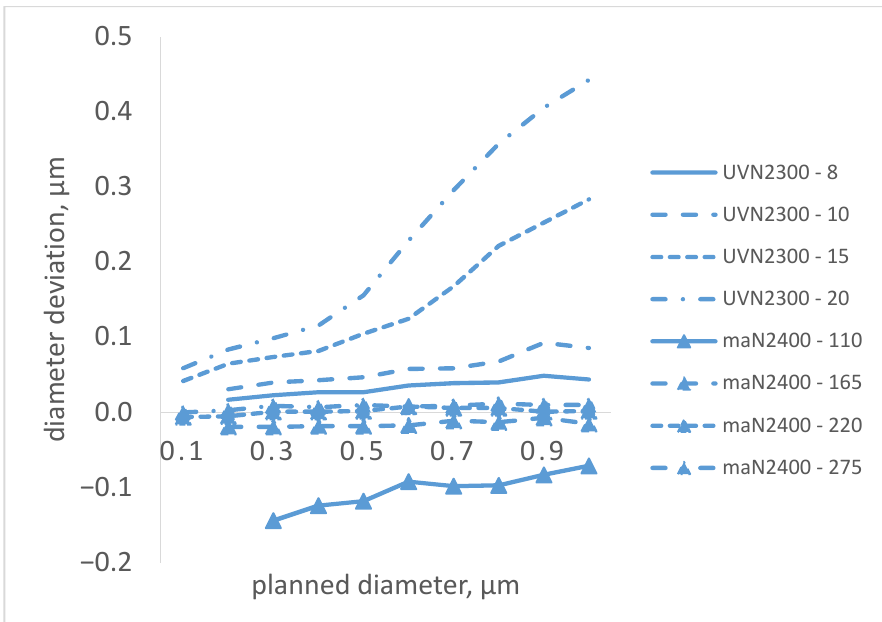
Figure 6. Deviation of the size of tunnel junctions during exposure and development (TMAH 2.4%, time 60 s) for ma-N 2400 and UVN 2300-0.5 resists. The horizontal axis is the planned diameter. The vertical axis is the difference in the diameter of the structures measured with an electron microscope minus the design value. Positive values correspond to a larger diameter than planned.